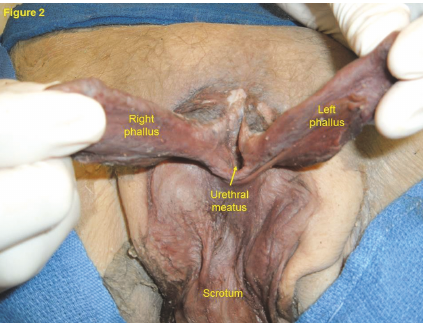
Figure 2: Proximal penoscrotal hypospadias. A urethral meatus opens directly at the base between each half and continues directly into a normally developed urinary bladder.